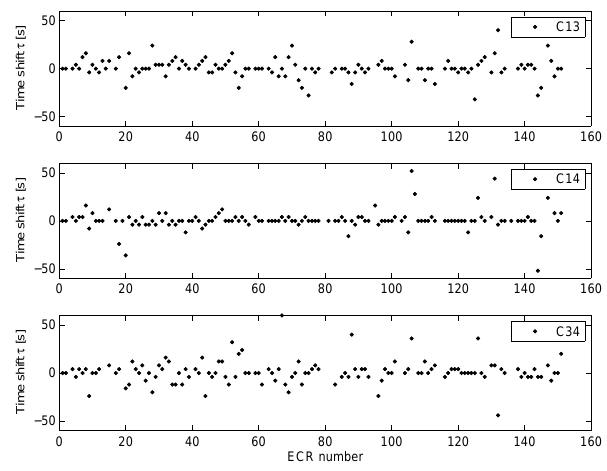
Fig. 4. The cross-correlation of power density signals from C1 and C3 (top panel), C1 and C4 (middle panel), C3 and C4 (bot- tom panel) is computed for each ECR according to Eq. (1). Nu- merically estimated time shift obtained from the maximum of the cross-correlation is plotted versus the ECR sequence number. We see that the most typical time shift is of the order of 0s, but 4s and above is also